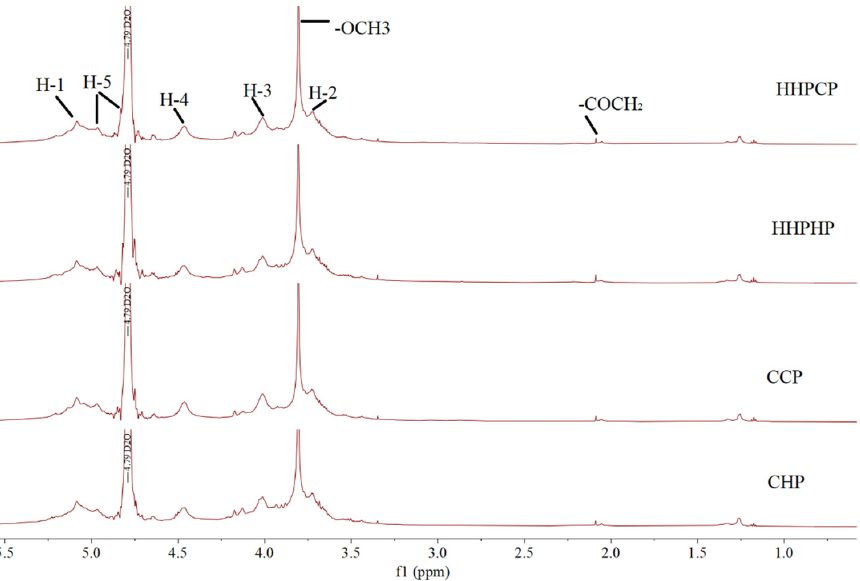
Figure 4. Effect of different extraction methods on 1 H-NMR spectra of Satsuma mandarin peel pectin.